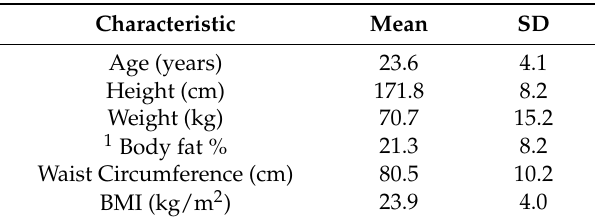
Table 2. Demographic characteristics of participants.